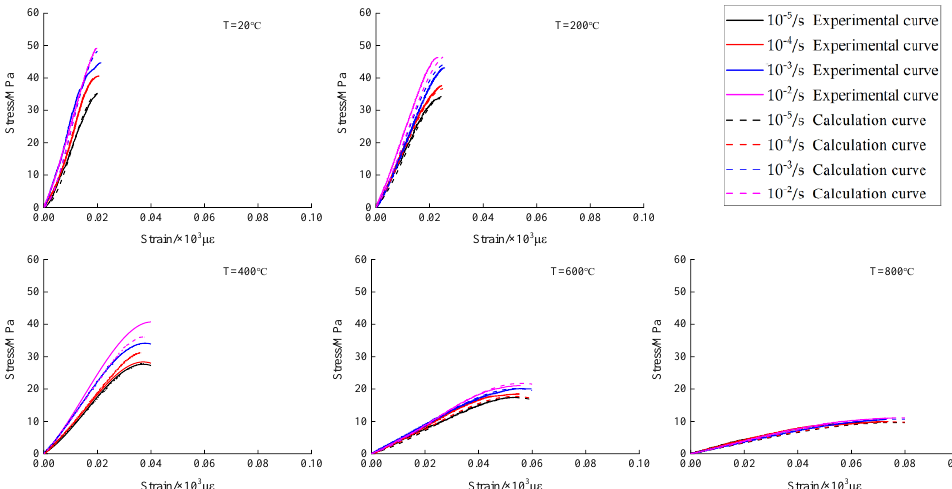
Figure 19. Comparison of test curves and calculated curves under dynamic strain rates of concrete after high temperature and rapid